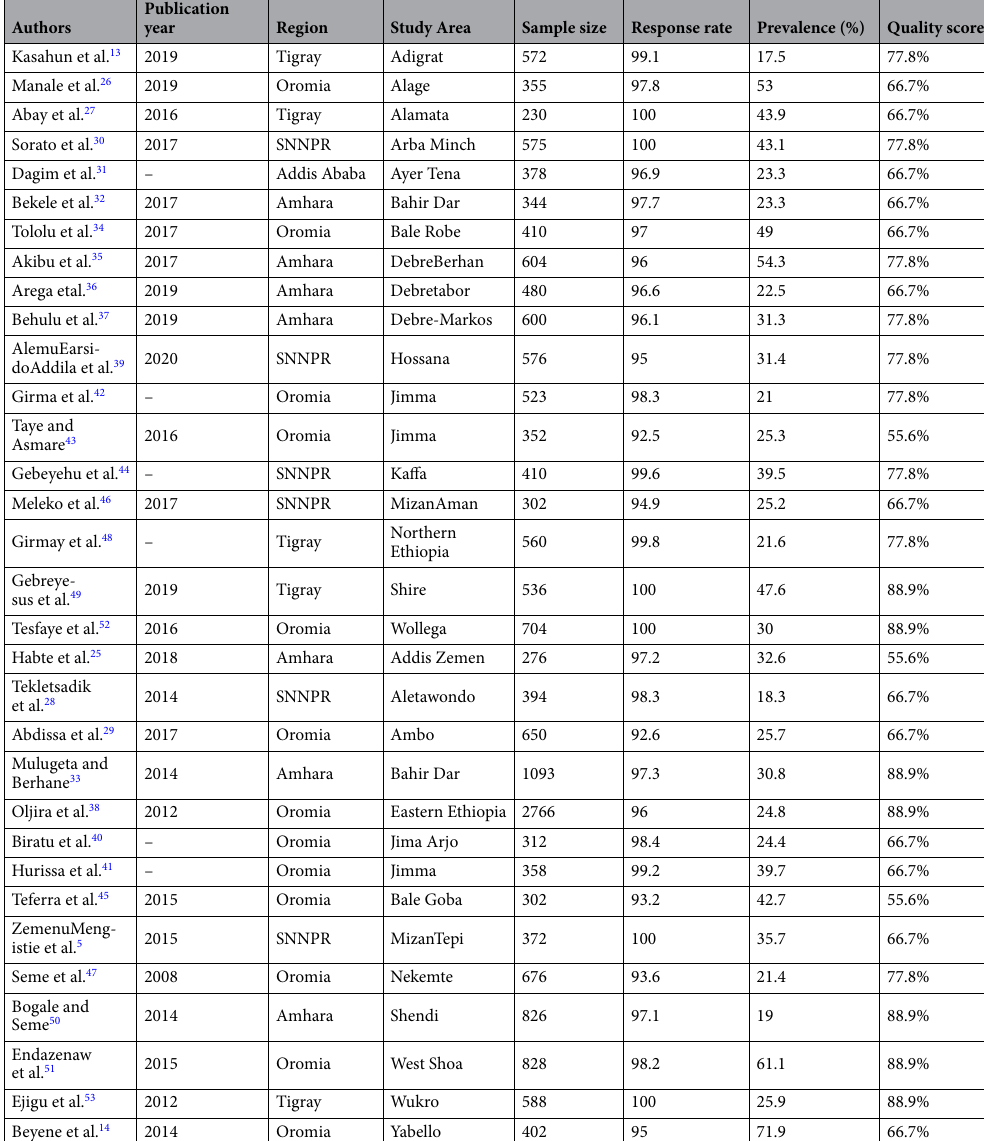
Table 1. Descriptive summary of thirty-two studies included estimating the pooled prevalence of premarital sexual practice and associated factors among students in Ethiopia, 2021. SSNPR-Southern Nations, Nationalities, and Peoples